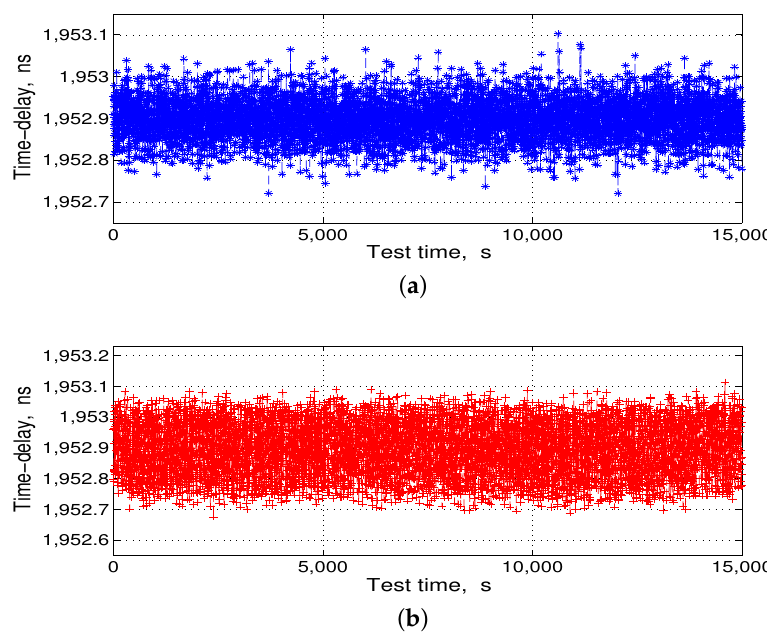
Figure 11. Transmission-delay compensation comparison test results. ( a ) test at 14 ◦ C; and ( b ) test at − 30–60 ◦ C.